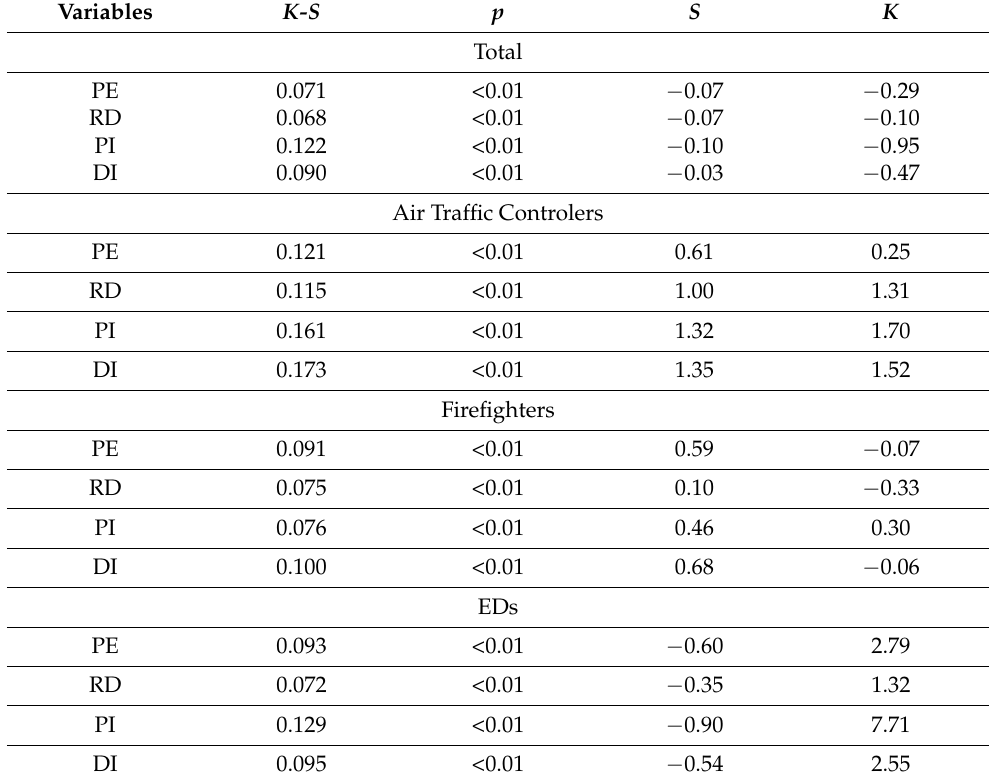
Table 2. Normality test for dimensions of occupational